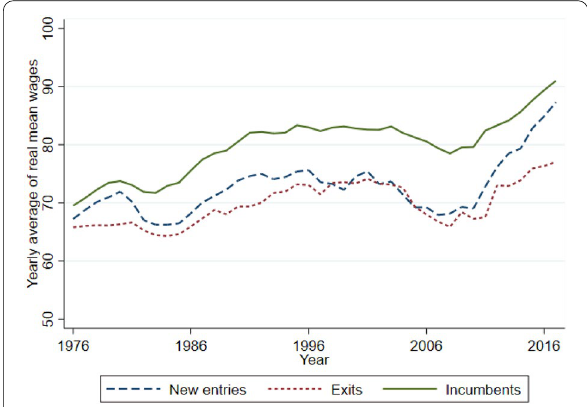
Fig. 2 Mean establishment’s wages in real terms in West Germany